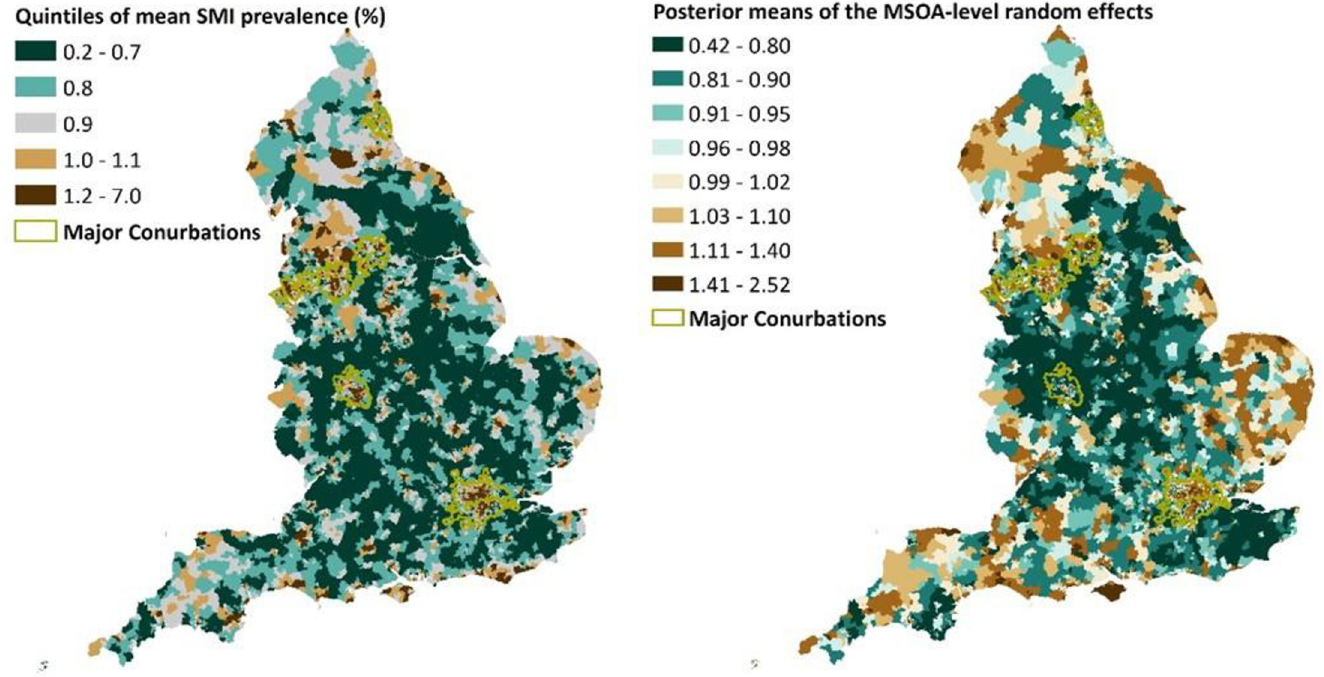
Fig 4. Mean SMI mean prevalence (quintiles) between financial year April 2014–March 2018 (left); posterior means of the MSOA-level random effects (right). (LSOA source: Source: Office for National Statistics licensed under the Open Government Licence v.3.0; Contains OS data Crown copyright and database right [2021].) LSOA, Lower Layer Super Output Area; MSOA, middle super output area; SMI, serious mental illness.